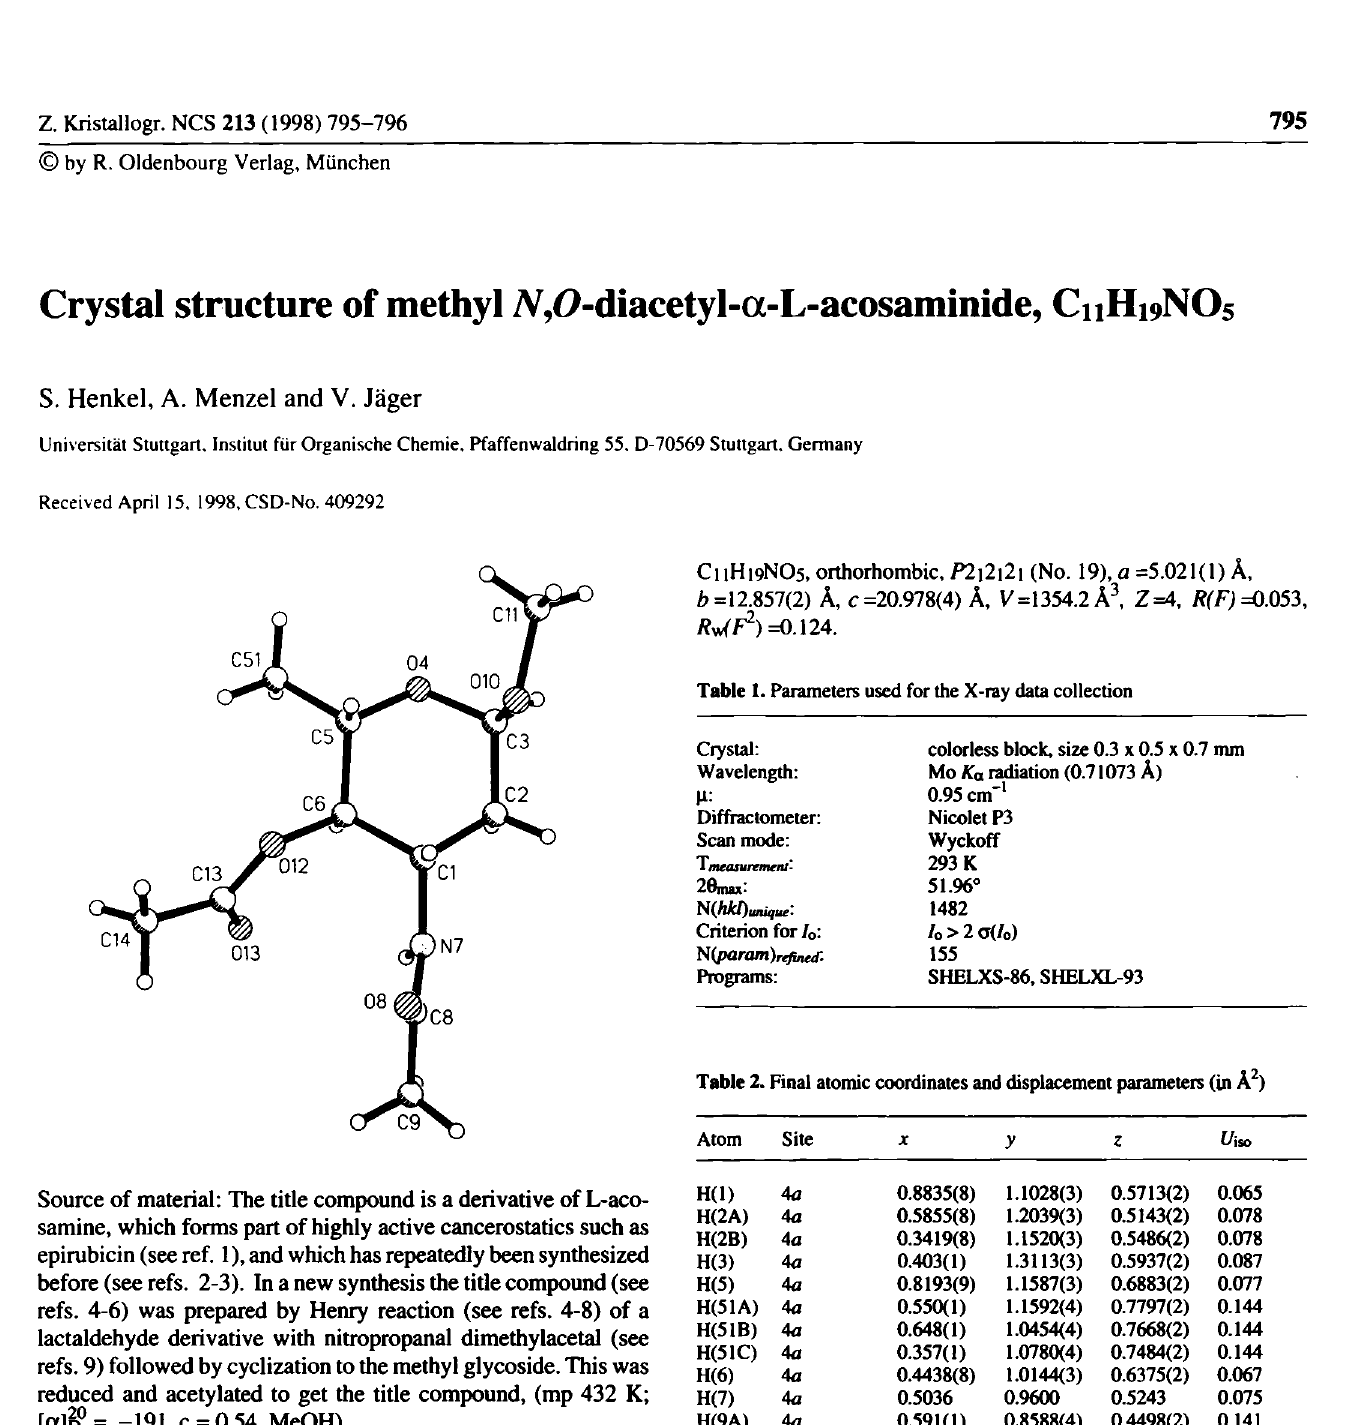
Table 3. Final atomic coordinates and displacement parameters (in Â^)